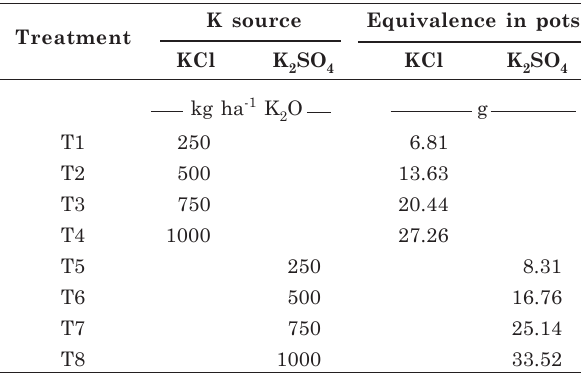
Table 1. Treatments and equivalent K contents per pot, based on two K 2 0 sources, KCl and K 2 SO